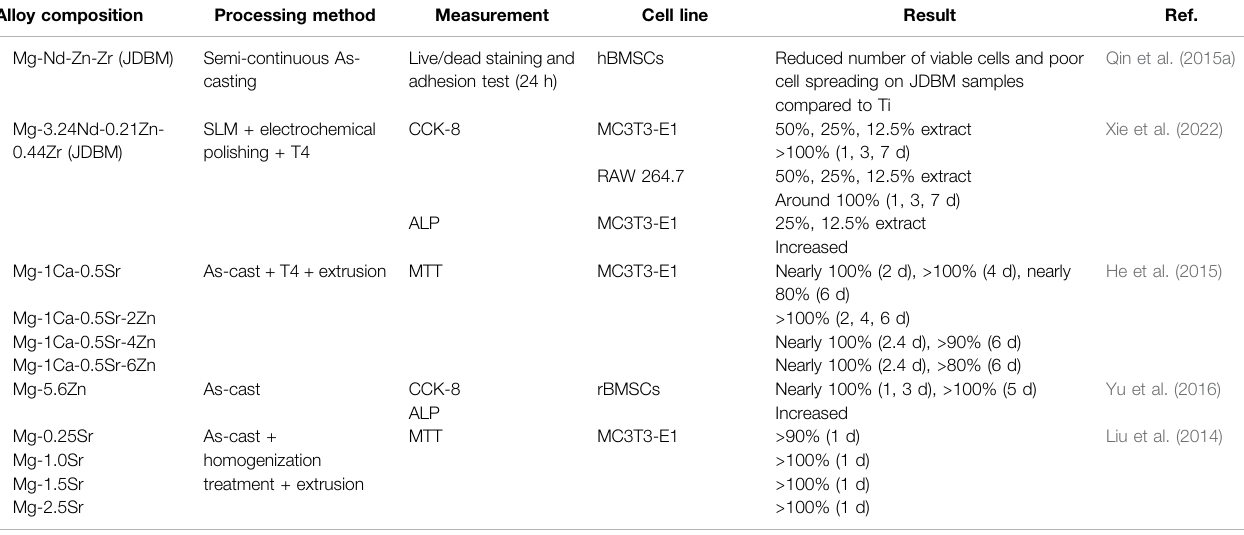
TABLE 4 | ( Continued ) In vitro biocompatibility of Mg-based alloys with antibacterial properties as orthopedic implants.